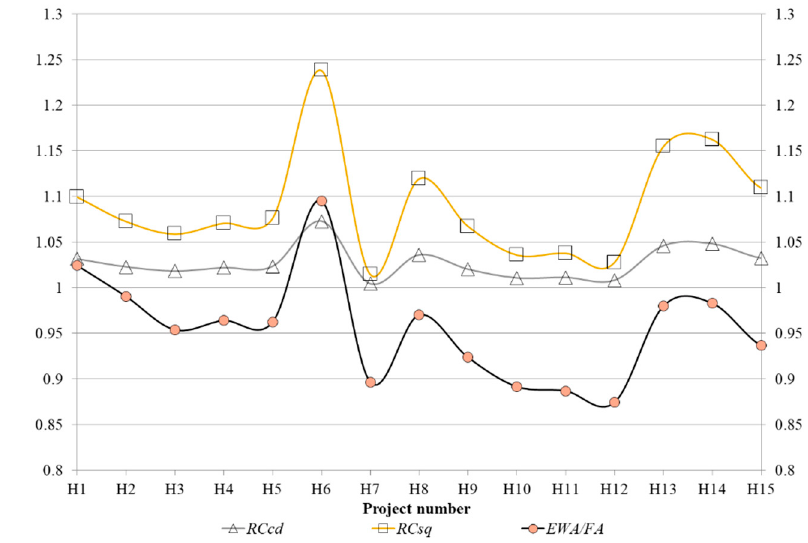
Figure 5. The clear correlation between the RC cd and EWA / FA indicators at the level correlation coefficient cor( RC cd , EWA / FA ) = 0.8665 in the limited range of the H1–H15 area variation (Table 1).